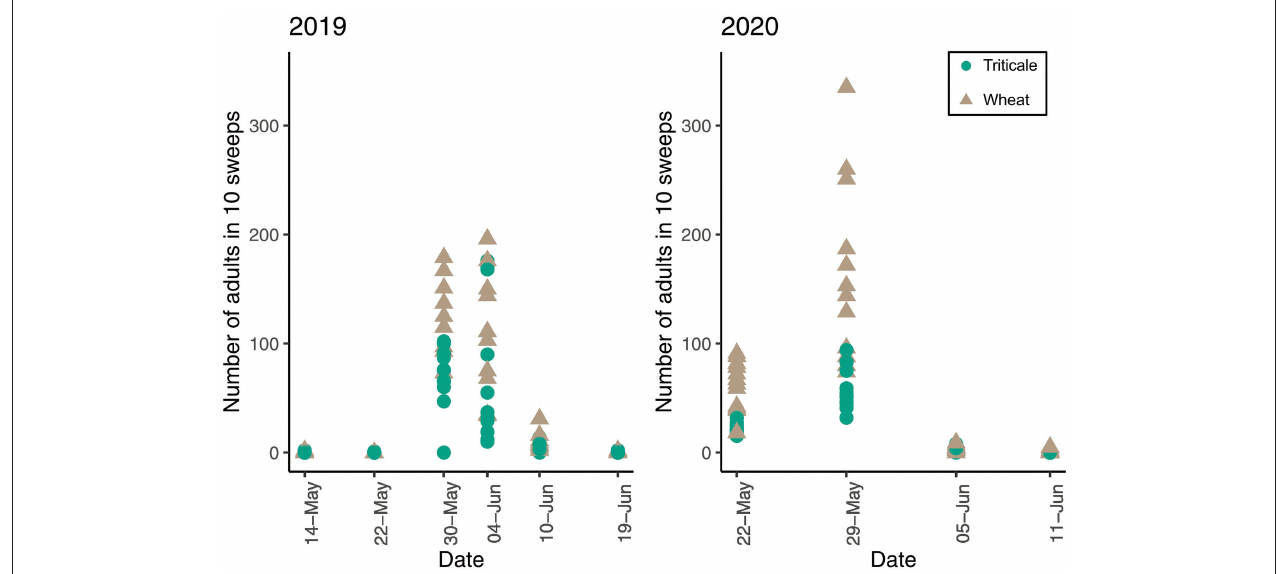
FIGURE 4 | Number of adult wheat stem sawfly caught in 10 sweeps in triticale and wheat plots during the 2019 and 2020 trap crop field trial. Points represent adults caught in plots.